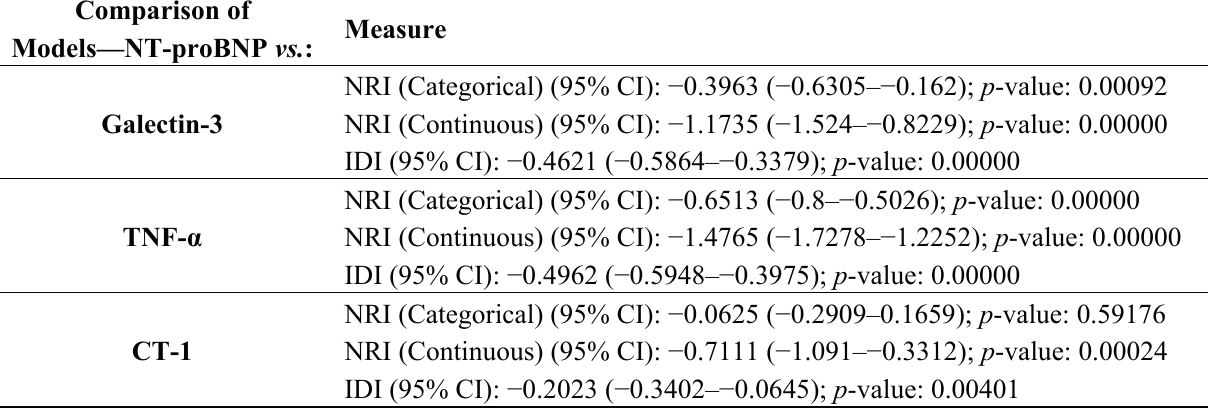
Table 5. Usefulness of biomarkers in the diagnosis of heart failure in comparison to the basic model